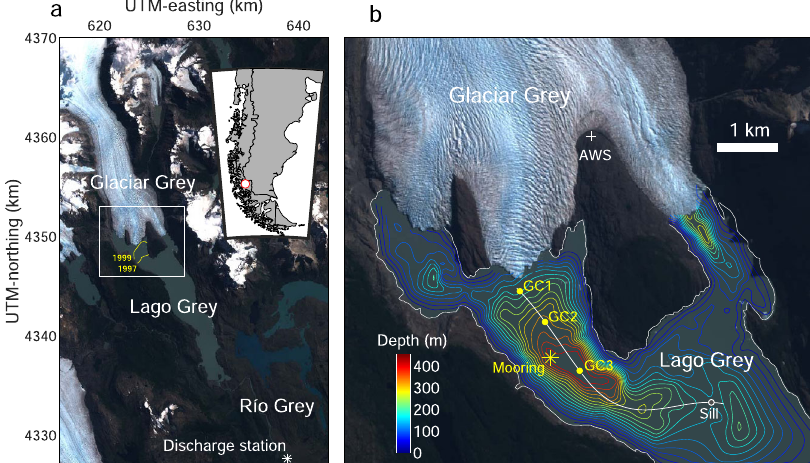
Fig. 1 Study site. a Satellite image of Glaciar Grey and Lago Grey (Landsat 8, 4 February 2017; UTM zone 18S). Inset and box show the location of the region in South America and the area covered by ( b ), respectively. The yellow curves show the glacier front positions in March 1997 and February 1999 as mapped by Landsat 5 images. The Río Grey discharge station is indicated by ( ✳ ). b Bathymetry of Lago Grey shown by contour lines with intervals of 25 m. Markers indicate the locations of the mooring ( ✳ ), temperature and turbidity pro fi ler casting ( ● ), automatic weather station ( + ), and sill mentioned in the text ( ○ ). The solid line shows the locations of the cross-section in Fig.